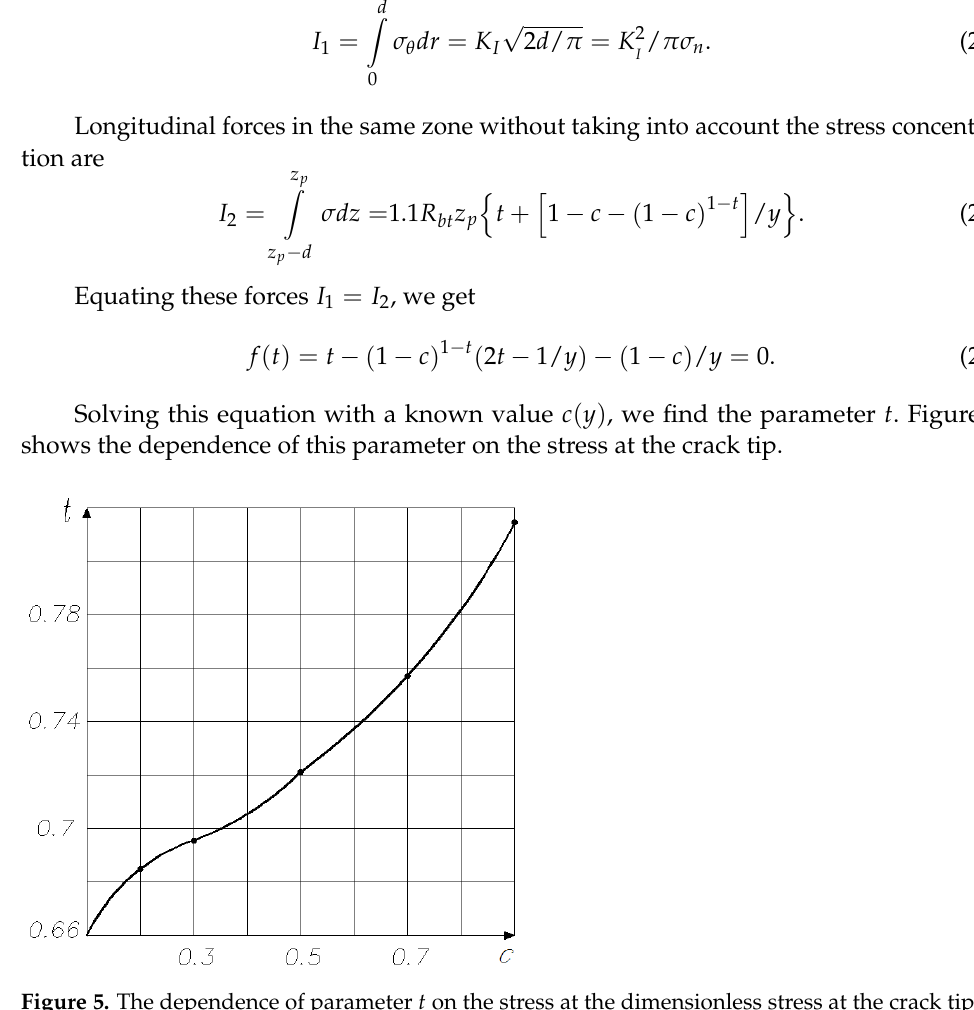
Figure 5. The dependence of parameter t on the stress at the dimensionless stress at the crack tip c .